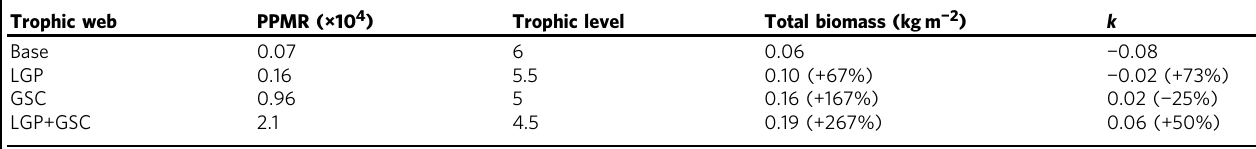
Table 1 Mean ecosystem properties for all four trophic webs over 5000 simulations Trophic web